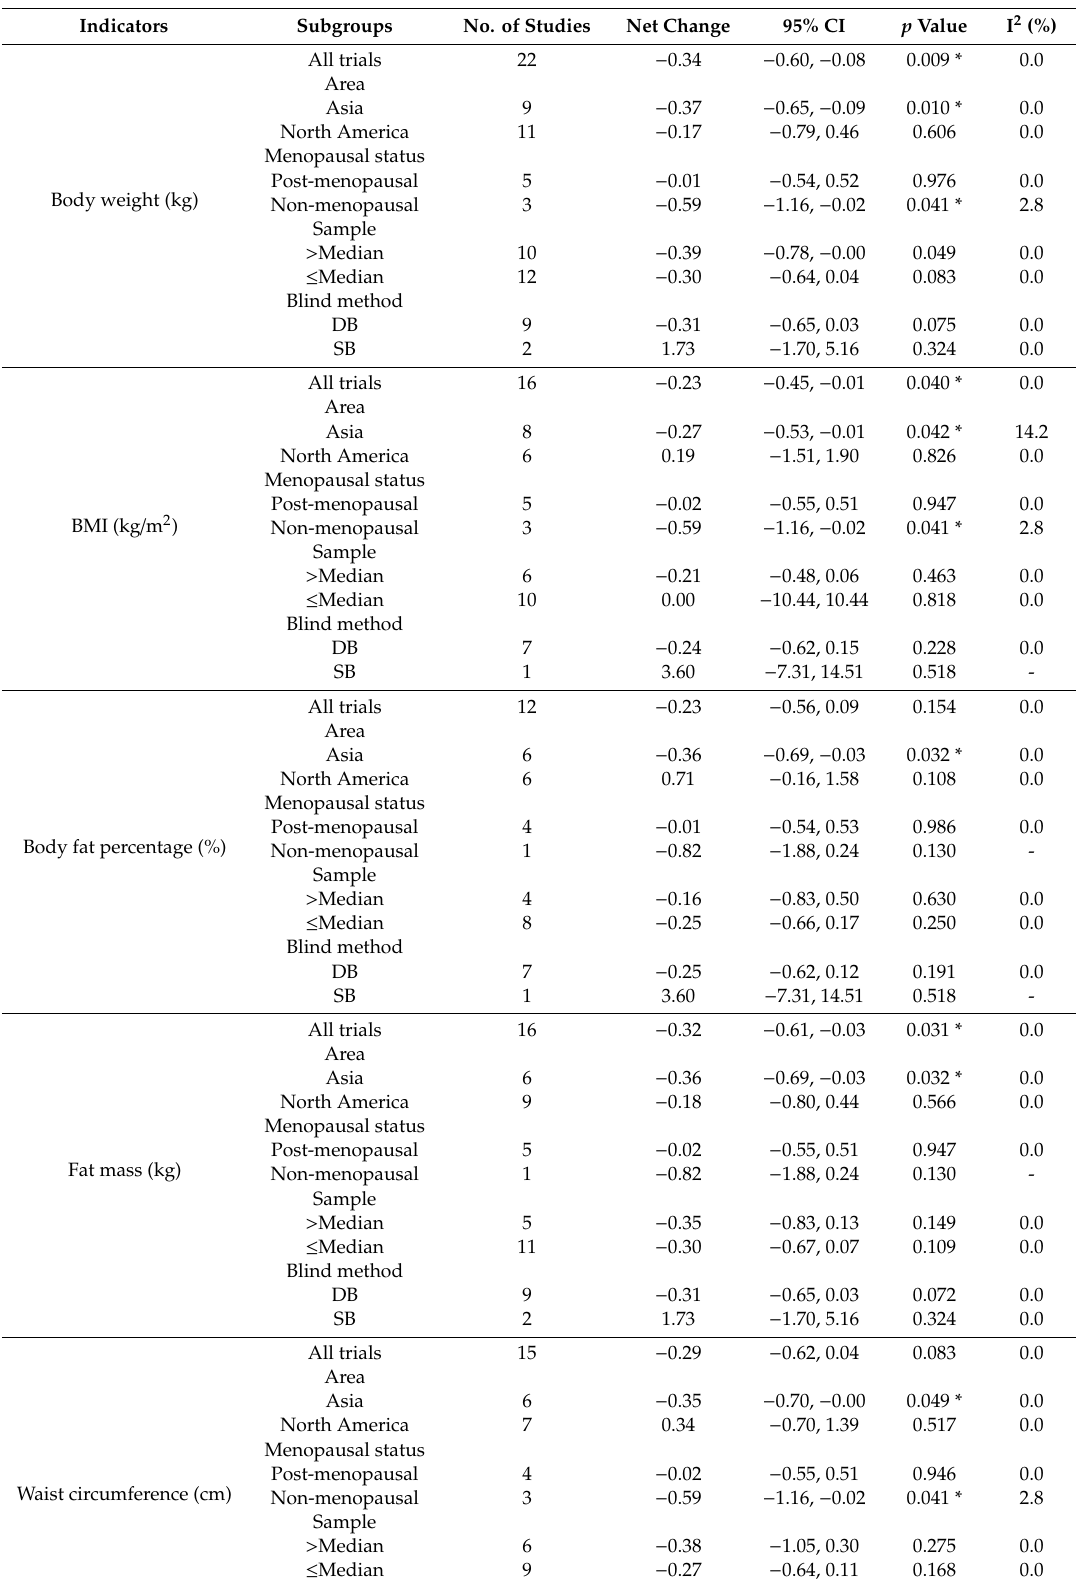
Table 3. Pooled estimates of treatment e ff ects on obesity-related anthropometric measures in subgroups of